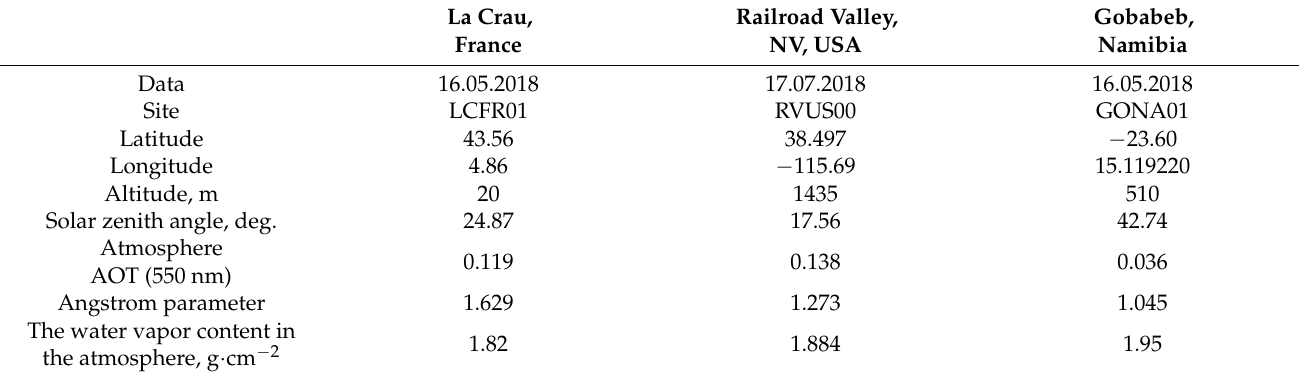
Table 15. Data on test sites and experimental conditions used for testing the RACE